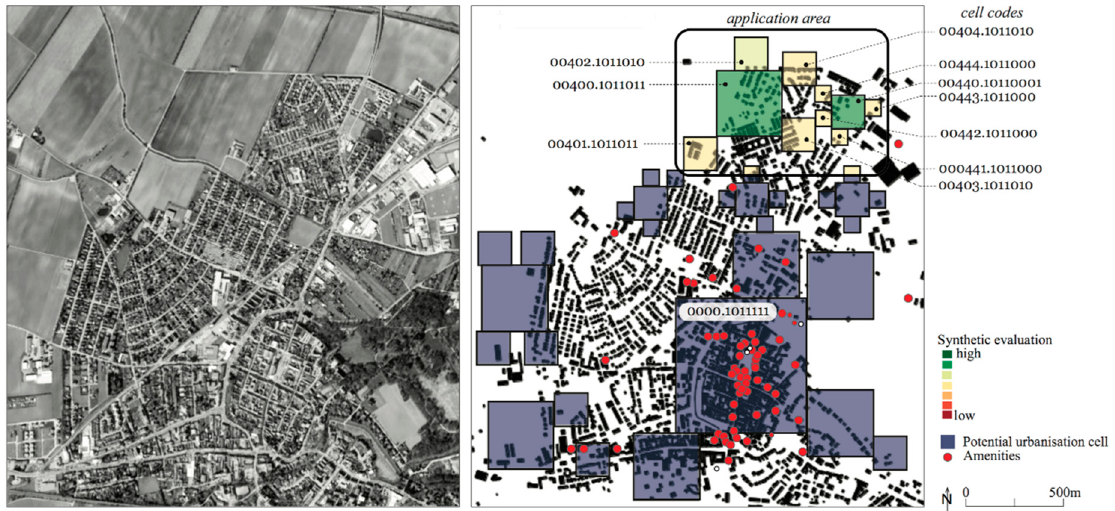
Figure 6. The strategic development plan on an urban scale at iteration Step 7; aggregated accessibility evaluation for selected cells in the application area (image left: google earth).